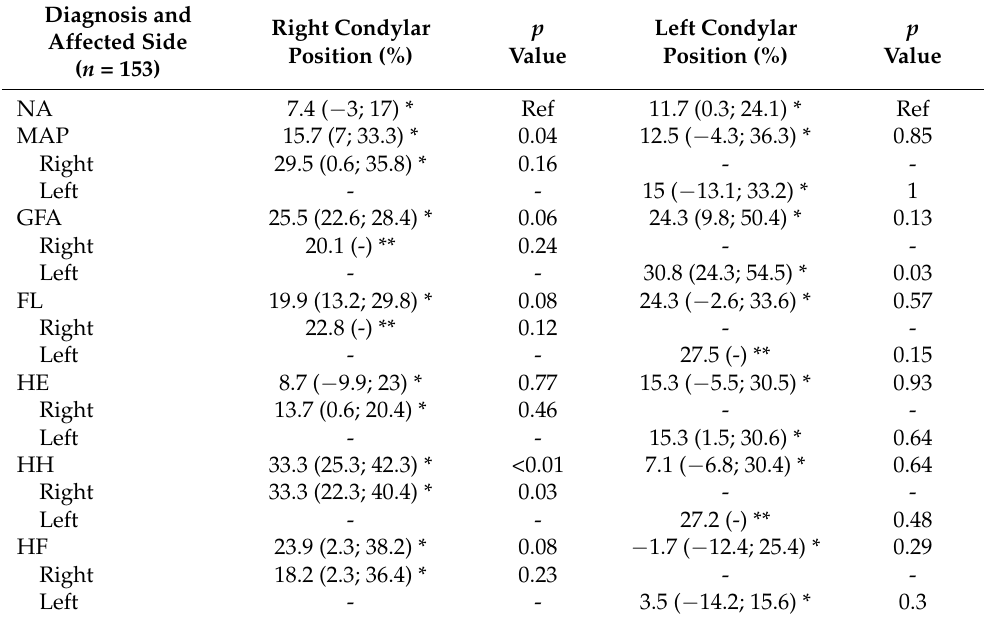
Table 5. Comparison of condylar position between affected sides and kind of FA vs. without FA. Diagnosis